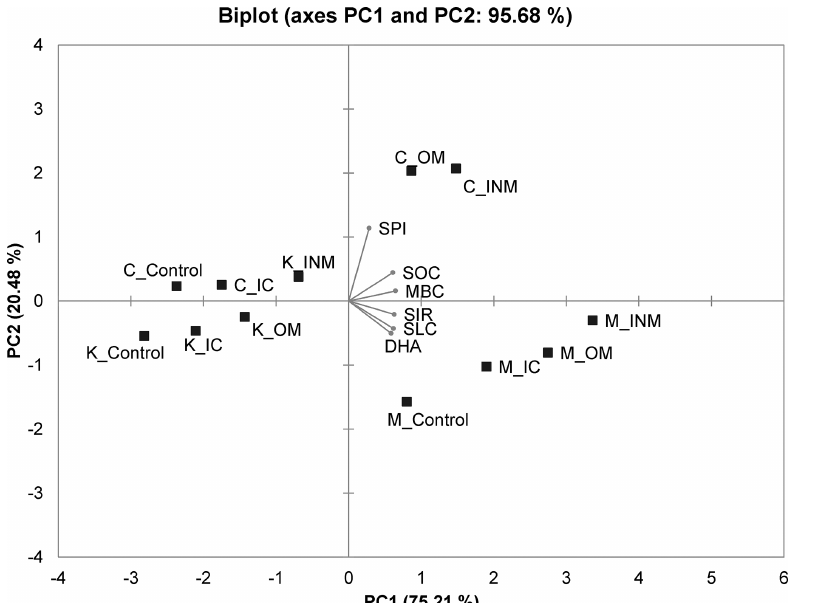
Figure 3. Principal component analysis biplot showing the relation between the soil biological variables in four different nutrient man- agement plots of three different agroclimatic zones of Tamil Nadu, India. SOC – soil organic carbon; MBC – microbial biomass carbon; SLC – soil labile carbon; SPI – soil protein index; DHA – dehydrogenase activity; SIR – substrate-induced respiration. Control – unfertilized control soil; IC – inorganic chemical fertilized soil; OM – organically managed soil; INM – integrated nutrient management enforced soil; C – Coimbatore; M – Madurai; K – Kovilpatti. The % variance explained by each component (PC1 and PC2) is given in parentheses in